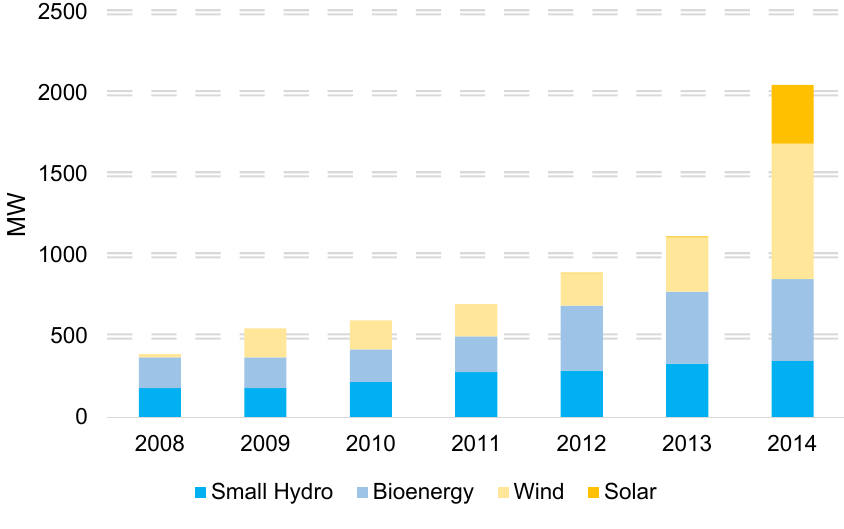
Figure 3. Evaluation of RES installed capacity in Chile between 2008 and